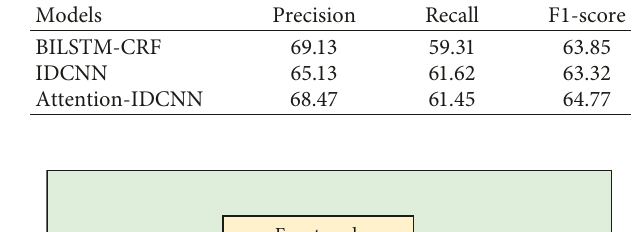
Table 6: Evaluation results of different models on the test set.